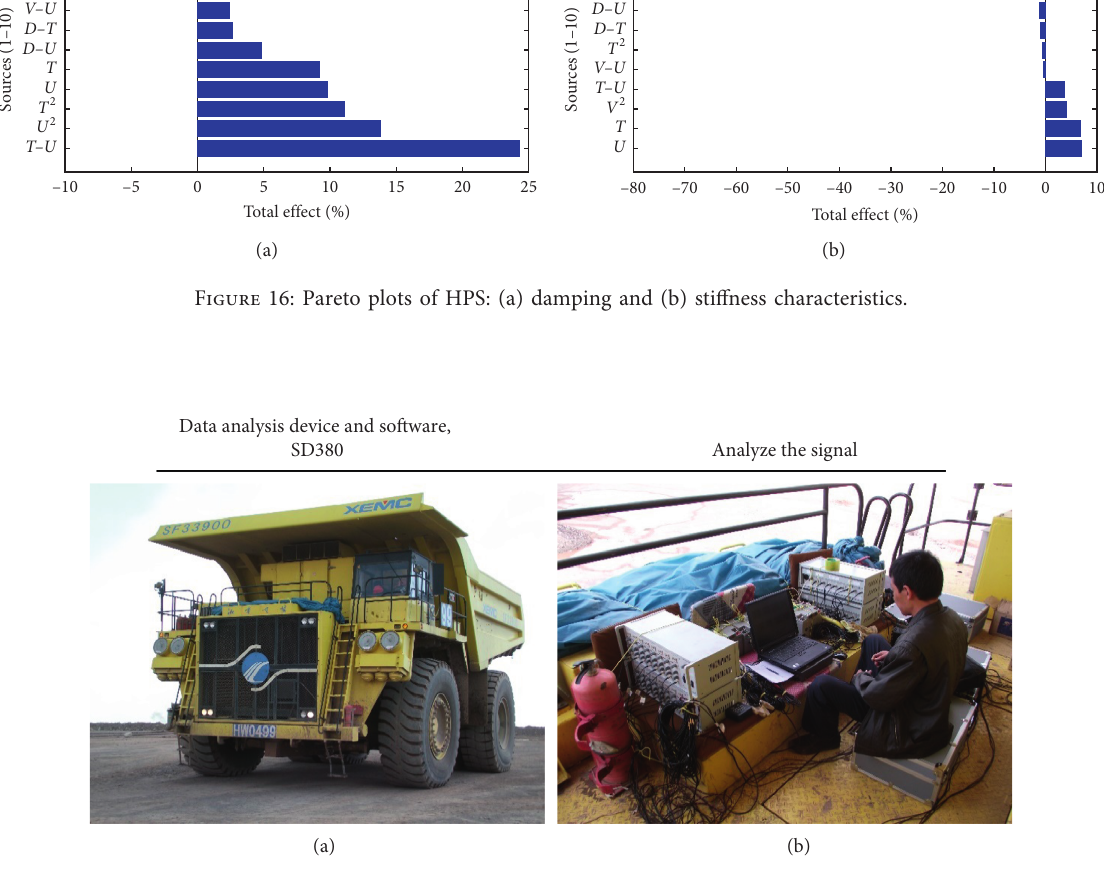
Figure 17: Mining dump truck and measurement